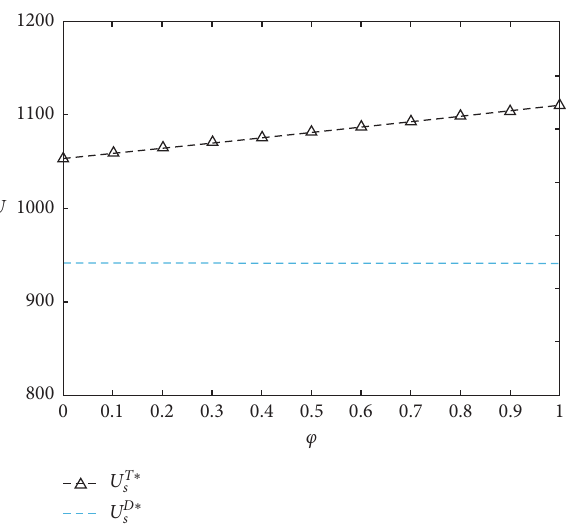
Figure 8: The effect of cost-sharing ratio on supplier